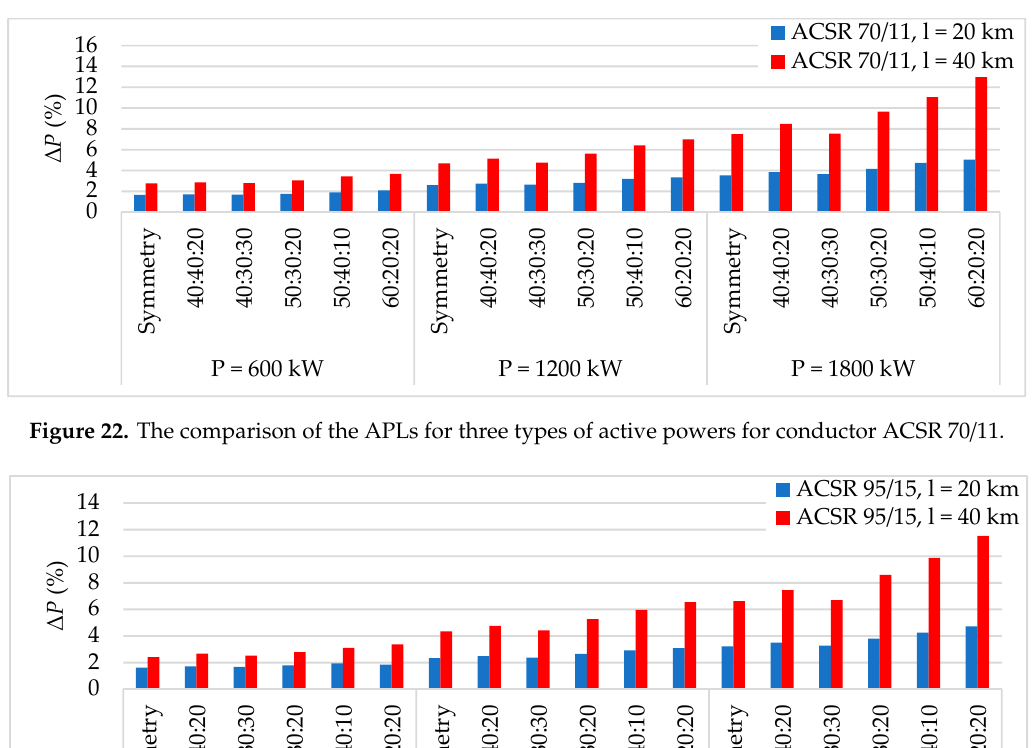
Figure 21. The comparison of the APLs for three types of active powers for conductor ACSR 42/7.